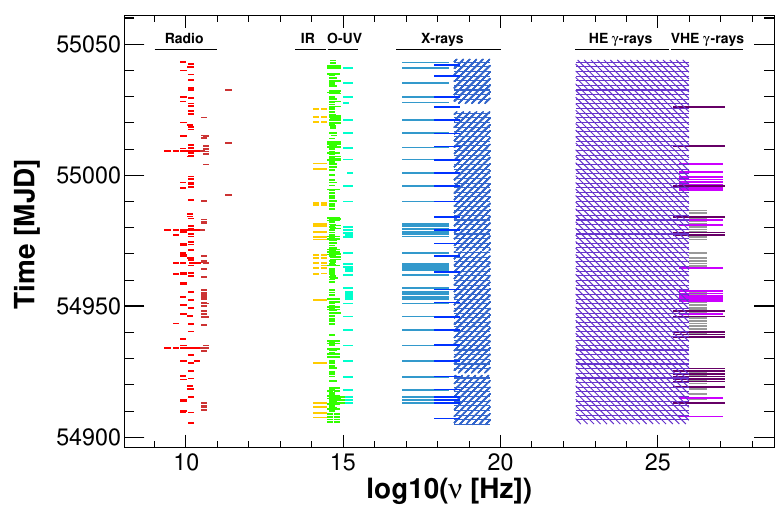
Figure 2. Time and energy band coverage of the multi-wavelength campaign on Mrk501 in 2009, from Abdo et al. [68].